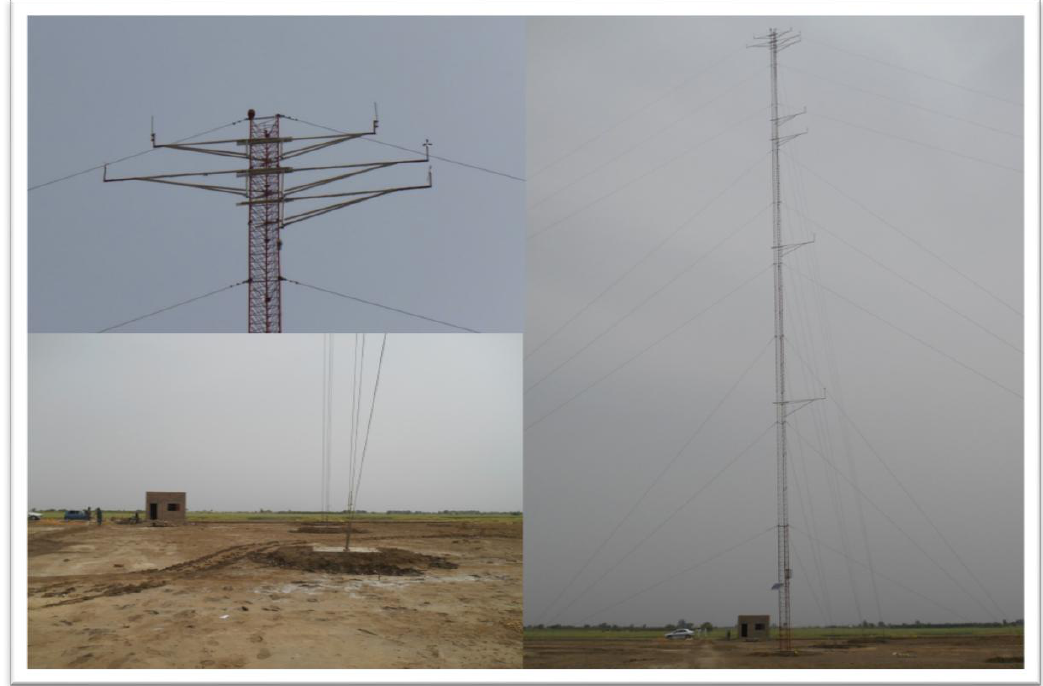
Figure 5. Wind mast and its surroundings at proposed site. (Right side of figure).The complete structure of wind mast, used for collecting wind data, (top left) microscopic view of tower top, (bottom Left) Microscopic view of tower ground.